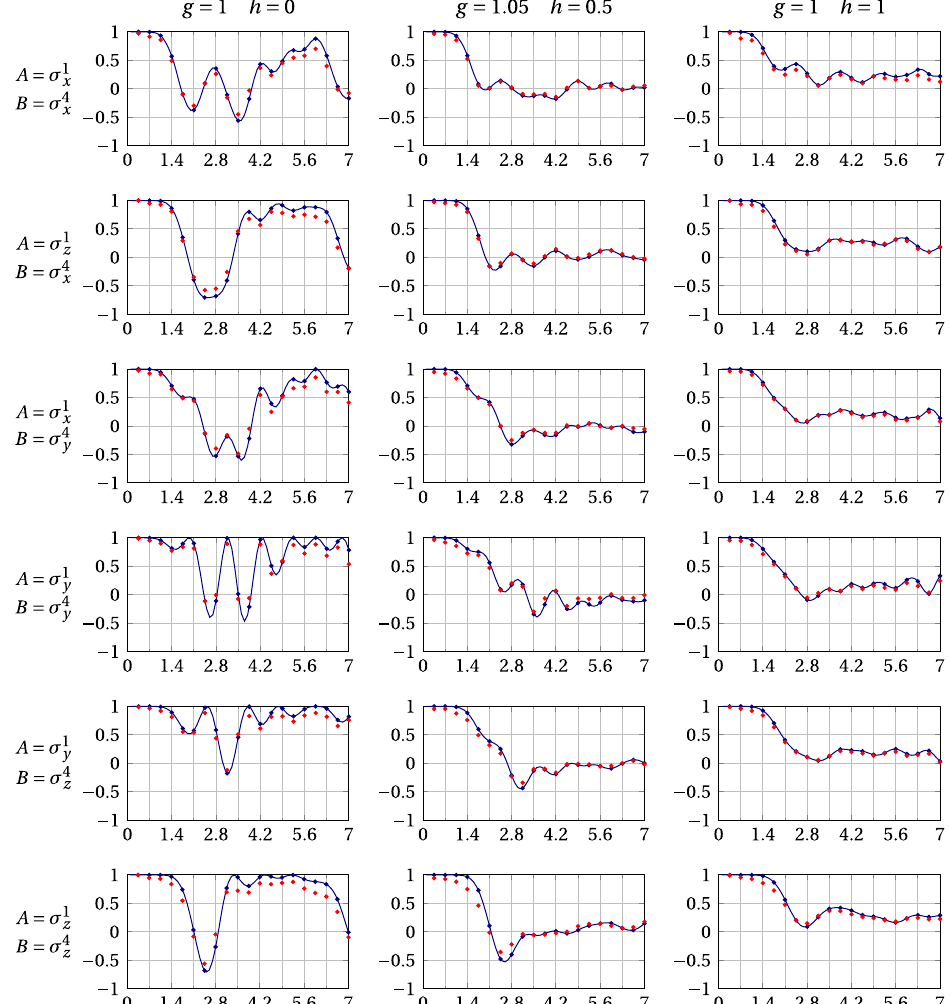
ˆ A and ˆ B . The red points